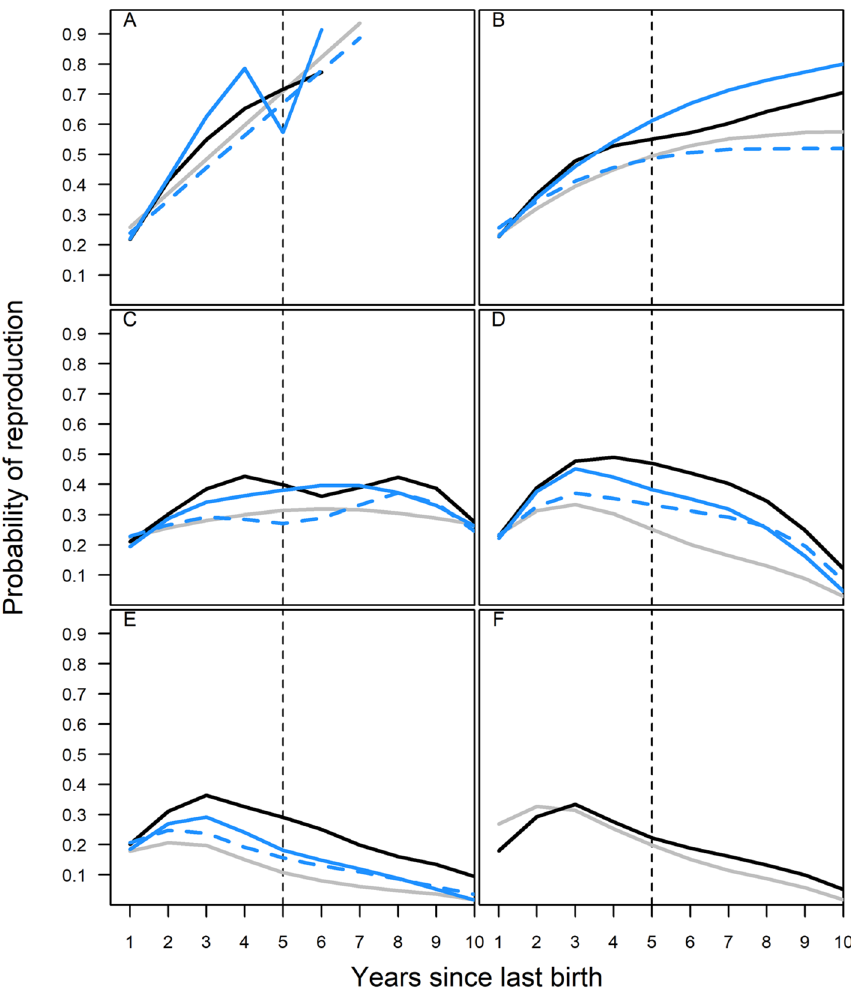
Figure 2. Mother presence and inter-birth interval effects on subsequent reproduction at different ages ( A – C ) and birth orders ( D – E ). Panels: ( A ) Mother/mother-in-law presence at age 25; ( B ) mother/mother- in-law presence at age 30; ( C ) mother/mother-in-law presence at age 35; ( D ) mother/mother-in-law presence for earlier-born children; ( E ) mother/mother-in-law presence when child birth order was greater than 4; ( F ) survival of previous child. Line colour in panels ( A – E ) indicates presence of mother and mother-in-law: grey = both dead, black = both alive, solid blue = mother alive, dashed blue = mother-in-law alive. In panel ( F ), grey indicates previous child was dead, and black indicates they were still alive. Birth order of the child was continuous in the models, but has been grouped in panels ( D ) and ( E ) following 13 . Smoothing splines fitted from model-predicted reproduction probabilities using the smooth.spline function. Vertical dashed line at year 5 shows the age at which the previous child would have got past the ‘toddler’ stage of life, and predicted reproductive probability thereafter would be less meaningful in regards to the Grandmother